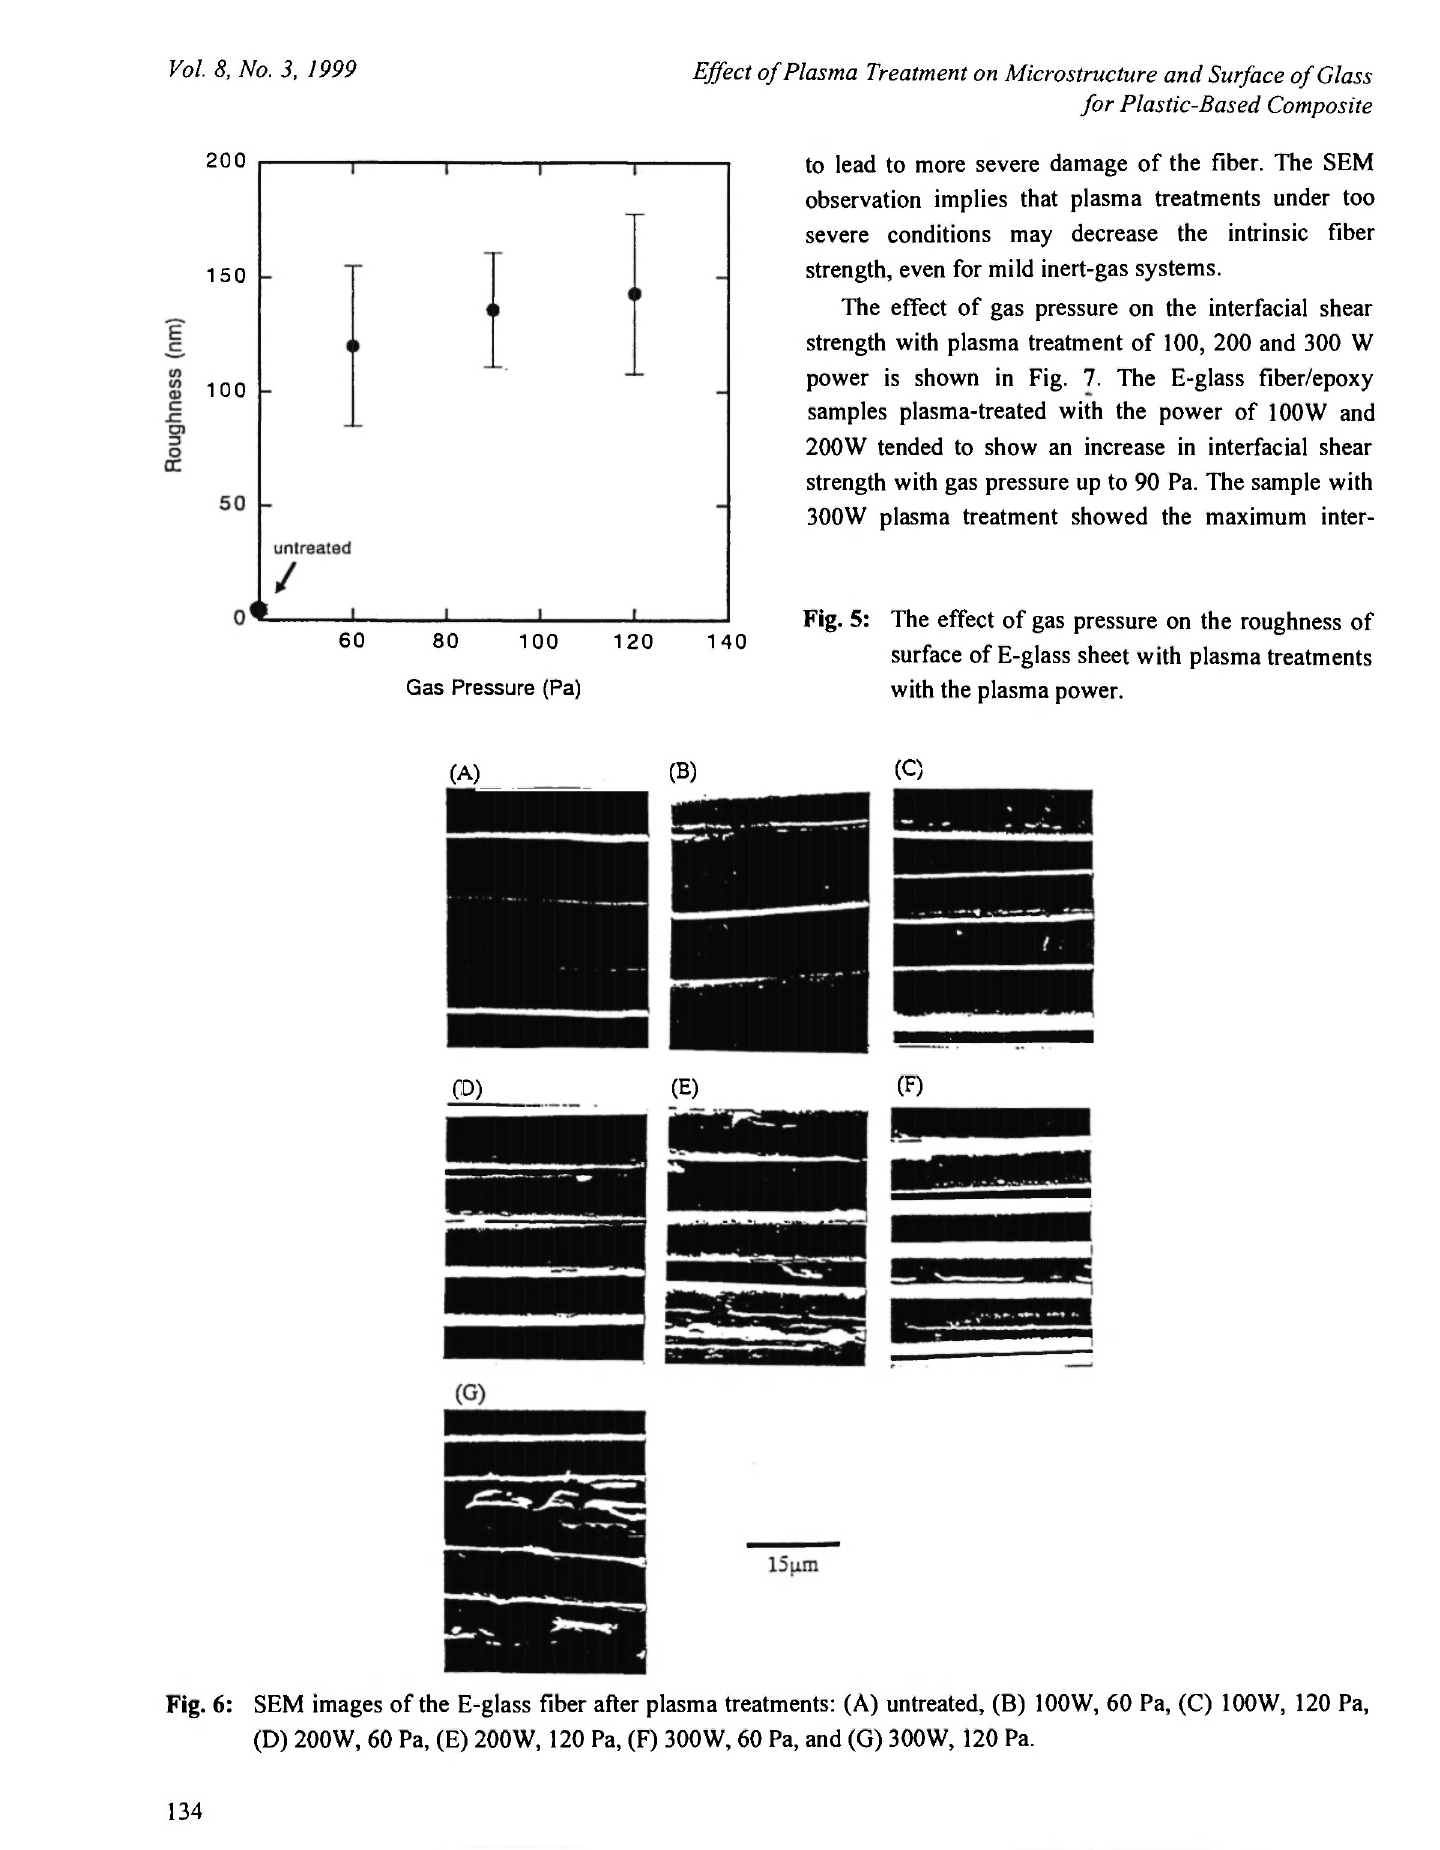
Fig. 6: SEM images of the Ε-glass fiber after plasma treatments: (A) untreated, (B) 100W, 60 Pa, (C) 100W, 120